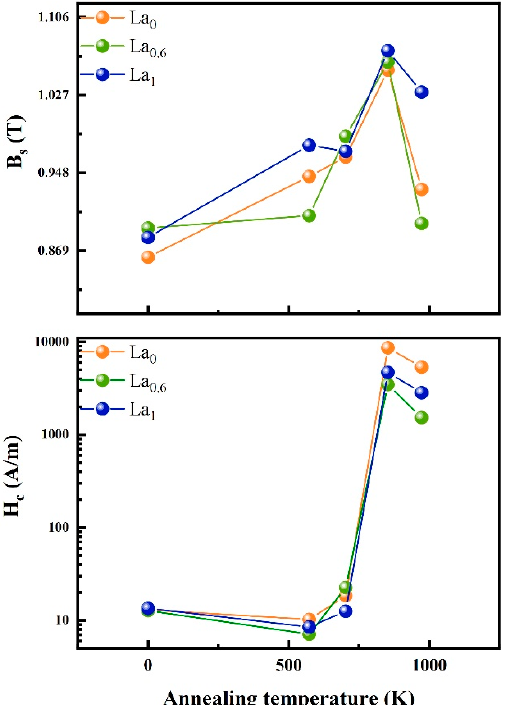
Figure 5. Changes in saturation magnetization ( B s ), coercivity ( H c ) with different annealing temper ‐ ature for Fe 27 Co 27 Ni 27 Si 10 − x B 9 La x ( x = 0, 0.6, 1) alloys. ture for Fe 27 Co 27 Ni 27 Si 10 − x B 9 La x ( x = 0, 0.6, 1)